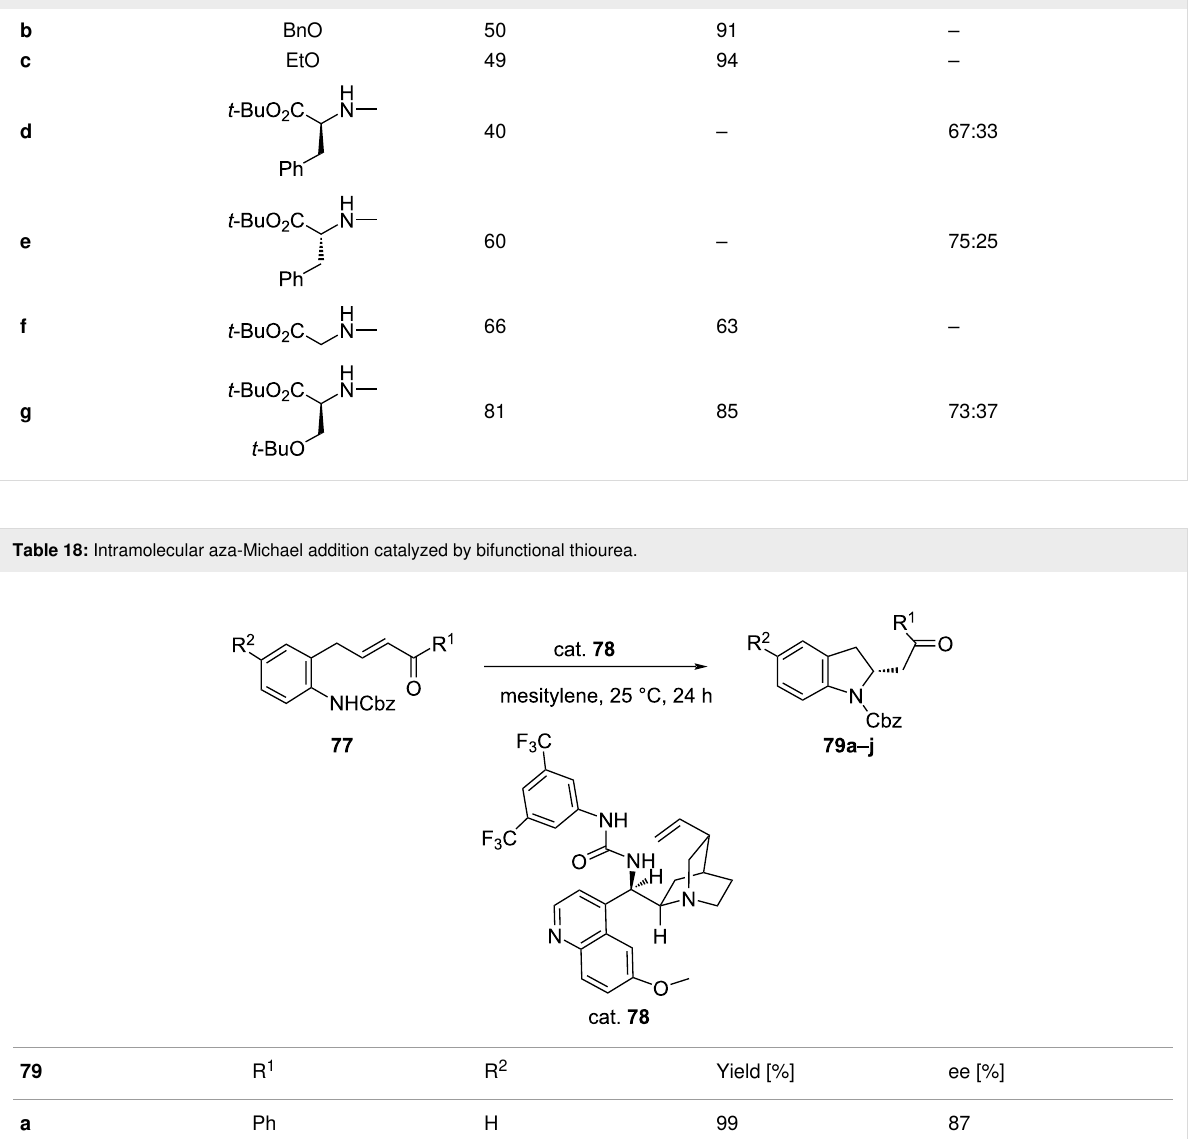
Table 17: Asymmetric aza-Michael addition reaction for the synthesis of N- hydroxyaspartic acid derivatives catalyzed by chiral multifunctional thio- urea/boronic acid. (continued)